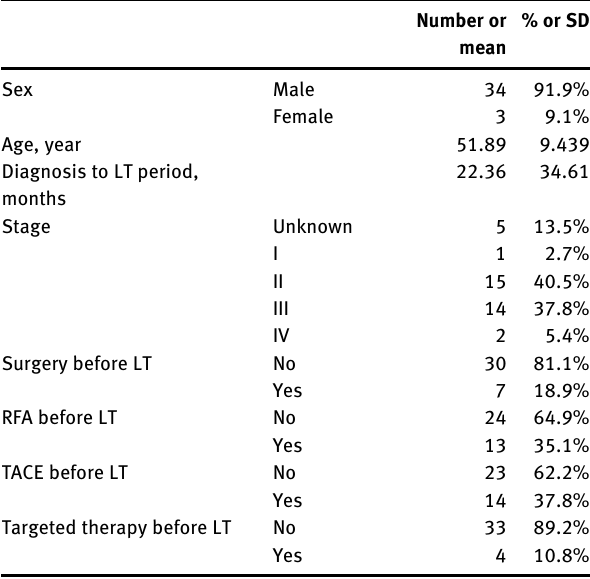
Table  : Clinical characteristics of included patients.